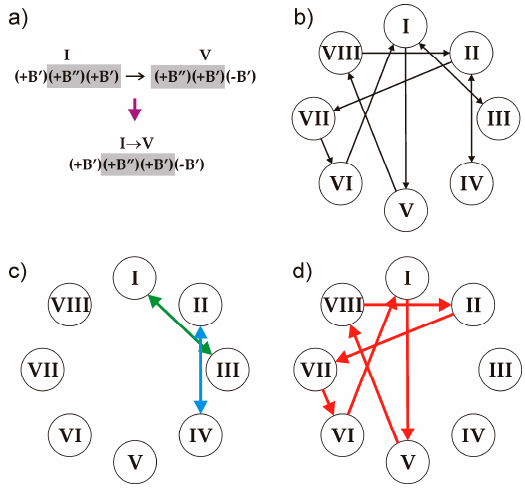
Figure 6. The illustration of the rule of overlapping triplets using the example of the I–V pair ( a ), the diagram of relations between the triplets ( b ), and the parts of diagram that result in the generation of clinokurchatovite ( c ) and kurchatovite ( d ) structures. See text for